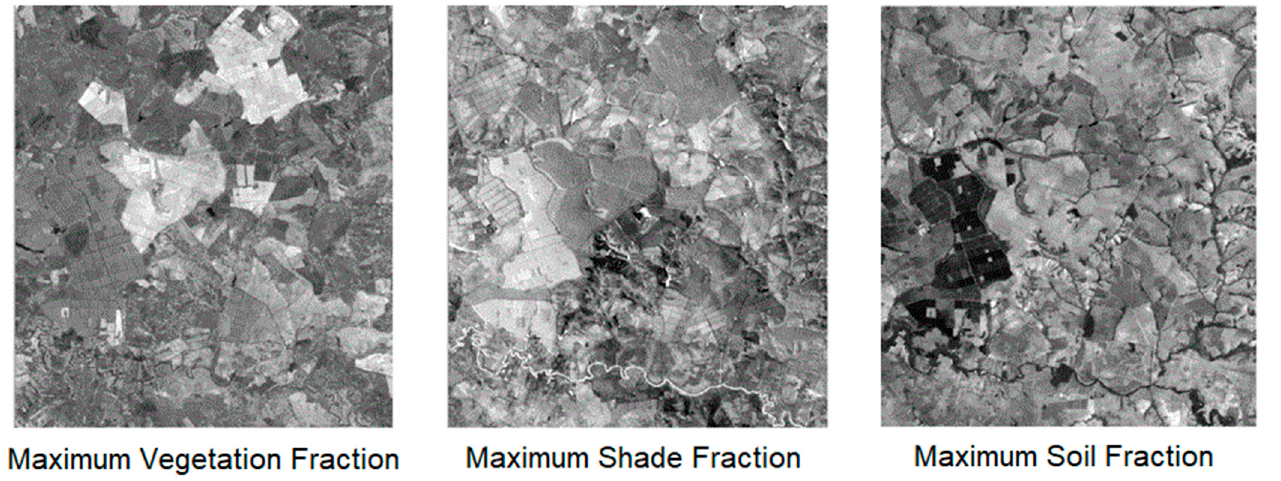
Figure 18. Maximum (vegetation, shade, soil) fraction images derived from TM time series (1985– 1995).